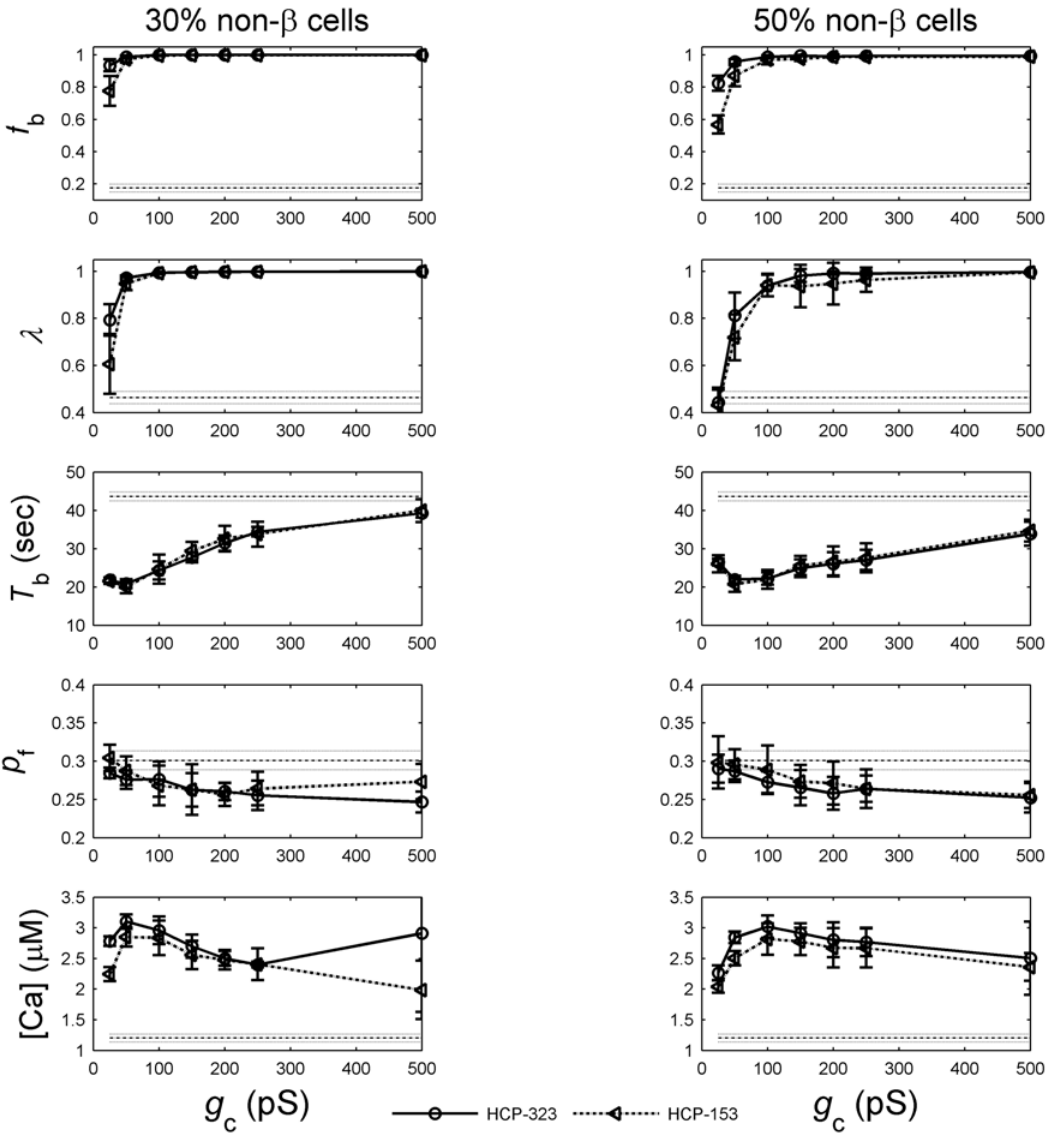
Figure 7. Function of b -cell clusters versus intercellular coupling strength g c .